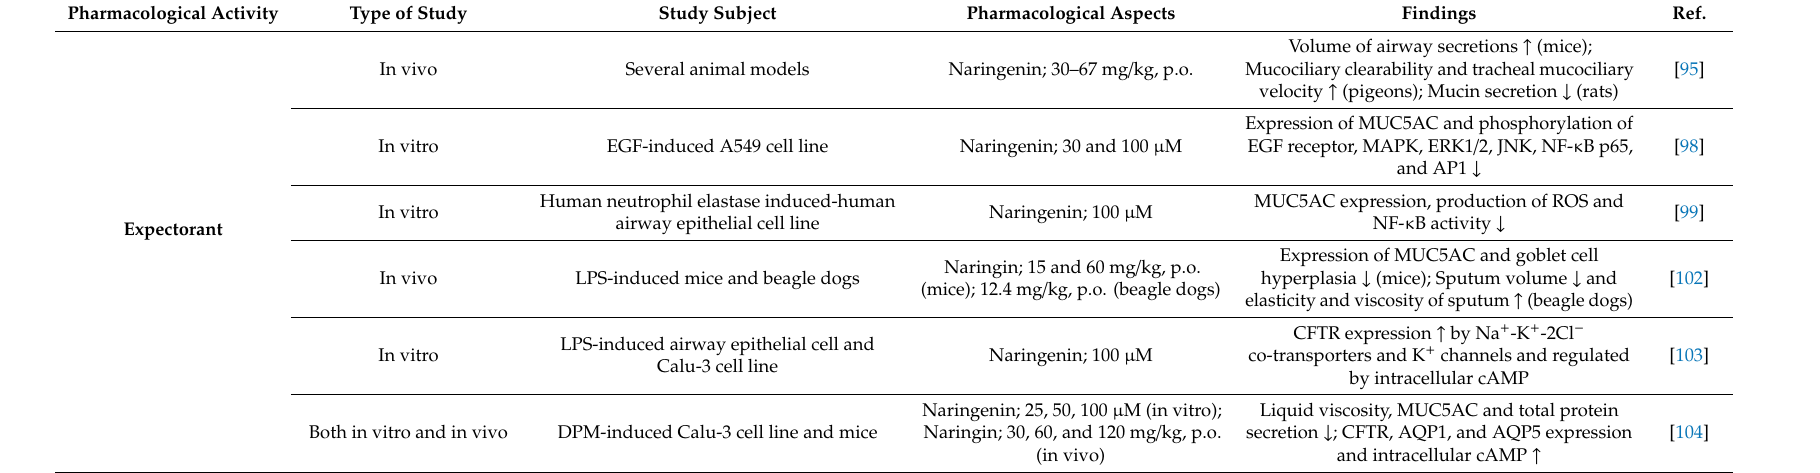
Table 5. Summary of expectorant e ff ects of naringenin and